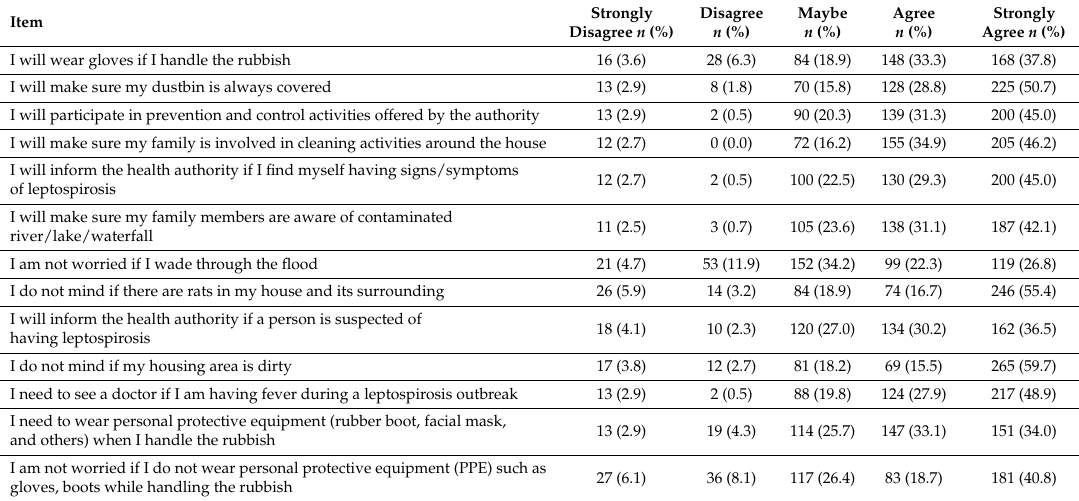
Table 2. Attitudes of leptospirosis among participants.